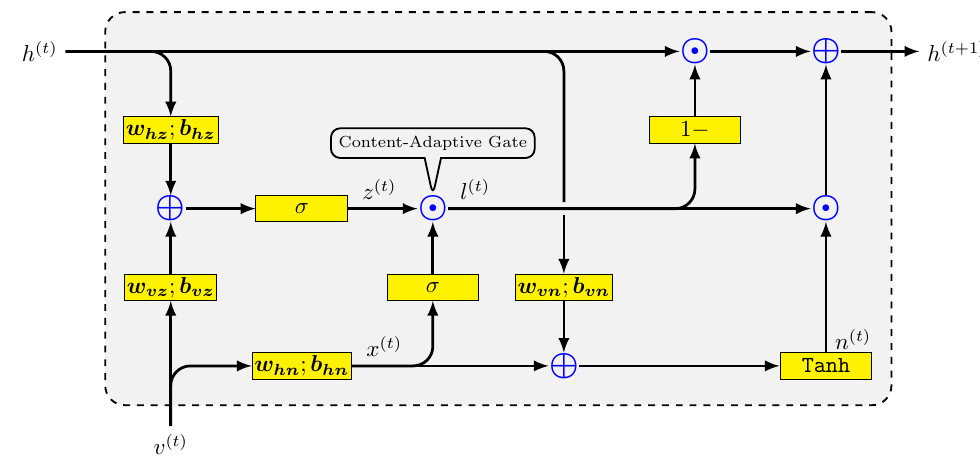
Figure 2. Architecture of single CARU